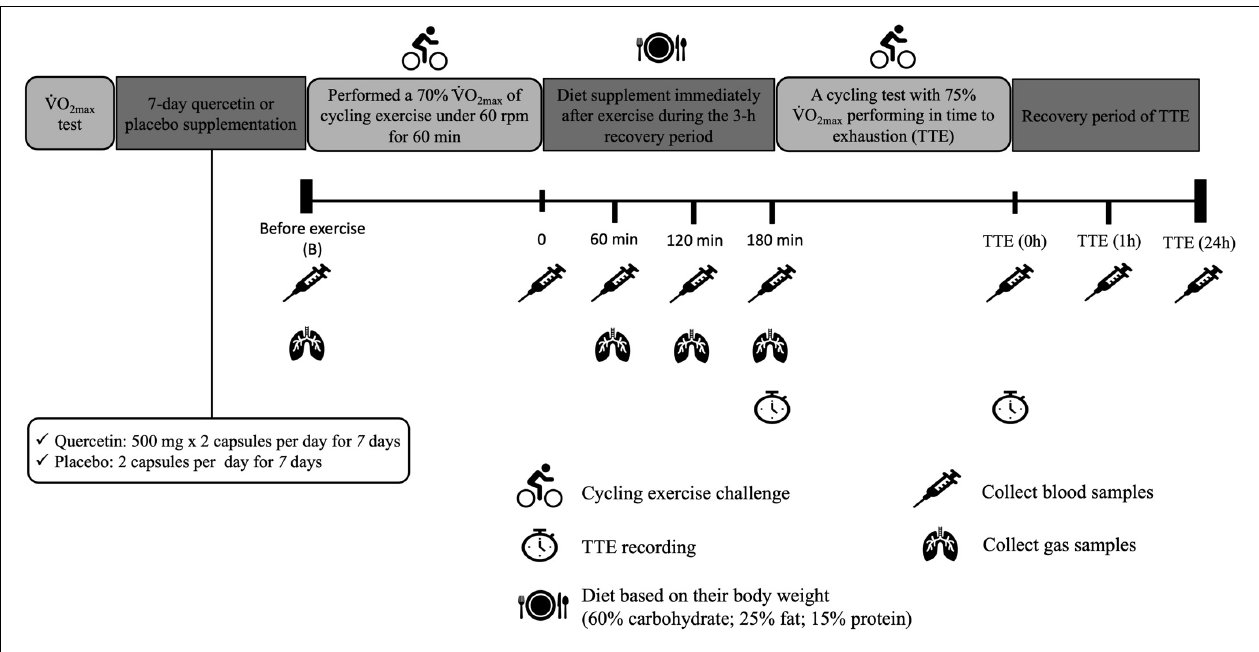
FIGURE 1 | Experimental design and protocol.